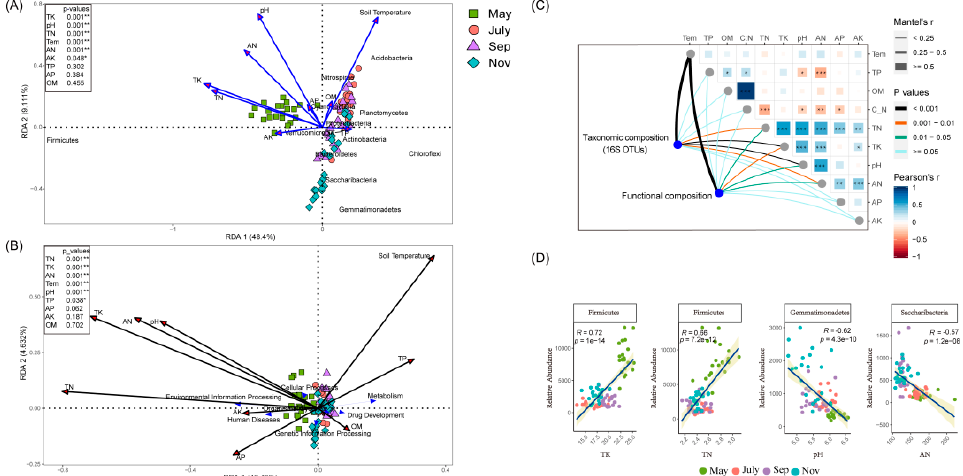
Figure 4. RDAs analysis between soil edaphic factors and bacteria phyla ( A ) and KEGG-L1 ( B ),